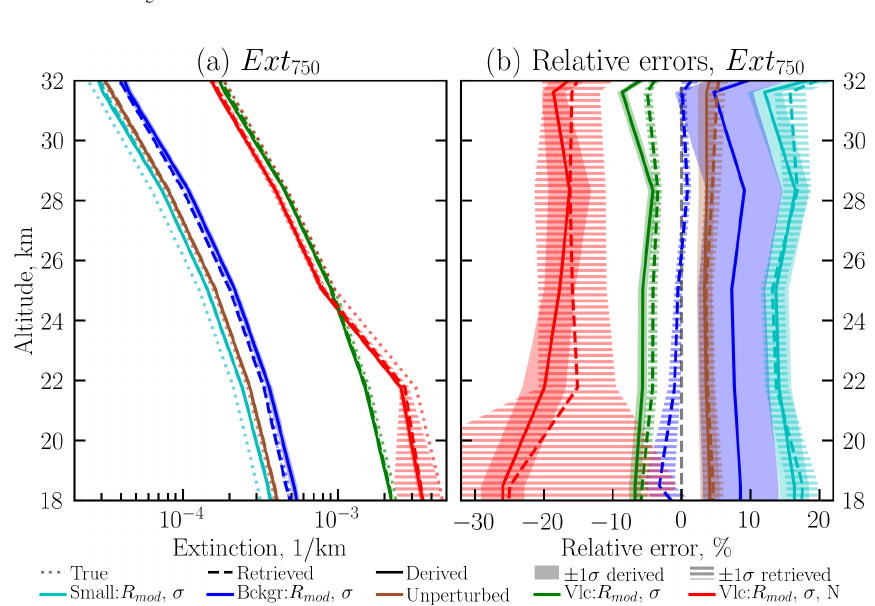
Figure 3. Profiles of Ext 750 (a) and their relative parameter errors (b) for a typical tropical observation geometry. The solid lines show the Ext 750 profiles calculated from the PSD product. Dashed lines depict the directly retrieved profiles, while the dotted lines represent the true values. The shaded areas stand for ± 1 standard deviation. The scenarios used for the simulations are listed in Table